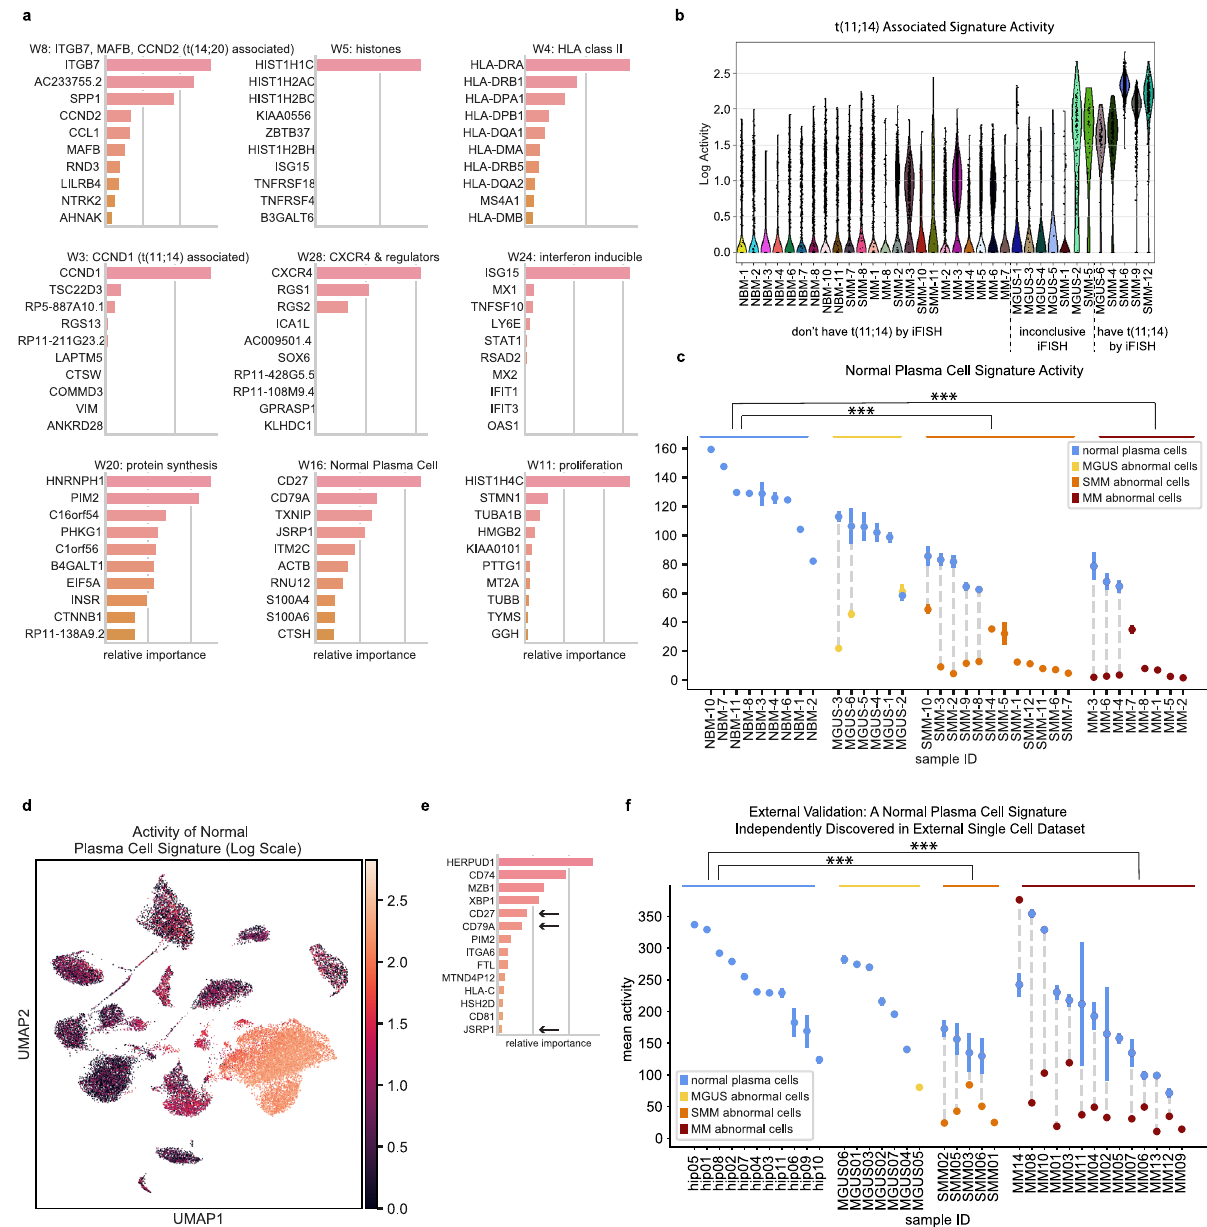
Fig. 3 | Bayesian non-negative matrix factorization uncovers gene signatures whichcapturemyelomacellbiologyacrossdiseasestages.a Top genesfornine representative gene signatures. The importance score, plotted on the x-axis, is based on both the strength of the gene ’ s contribution to the signature and its speci fi citytothesignature(seeMethods). b Asignaturewithtopcontributionfrom CCND1 isdiscoveredandismostactiveinsampleswitht(11;14),asexpected. c , d We discovera ‘ normalplasmacellsignature ’ thatisactiveinnormalplasmacellsacross disease stages and downregulated in abnormal cells from MM and precursor conditions. We visualize this signature ’ s activity by showing its mean activity ± s.e.m. for the normal and abnormal populations within each sample ( c ) and on a UMAP plot (logscale) ( d ).Meanactivitieswerecompared between groups, with*** denoting q <0.001 for group differences (abnormal cells from SMM ( n =12) and